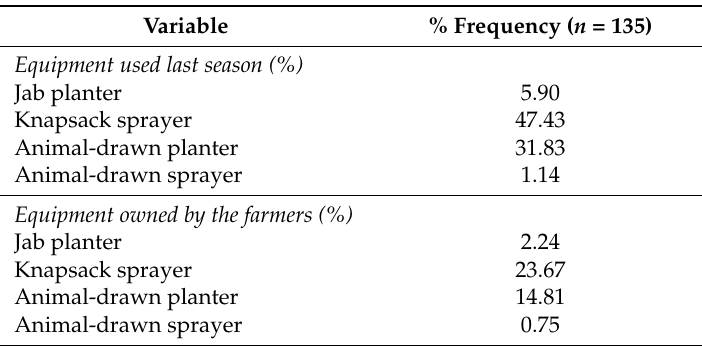
Table 6. Frequencies of sampled smallholder farmers’ access to and ownership of CA implements in the Eastern Cape